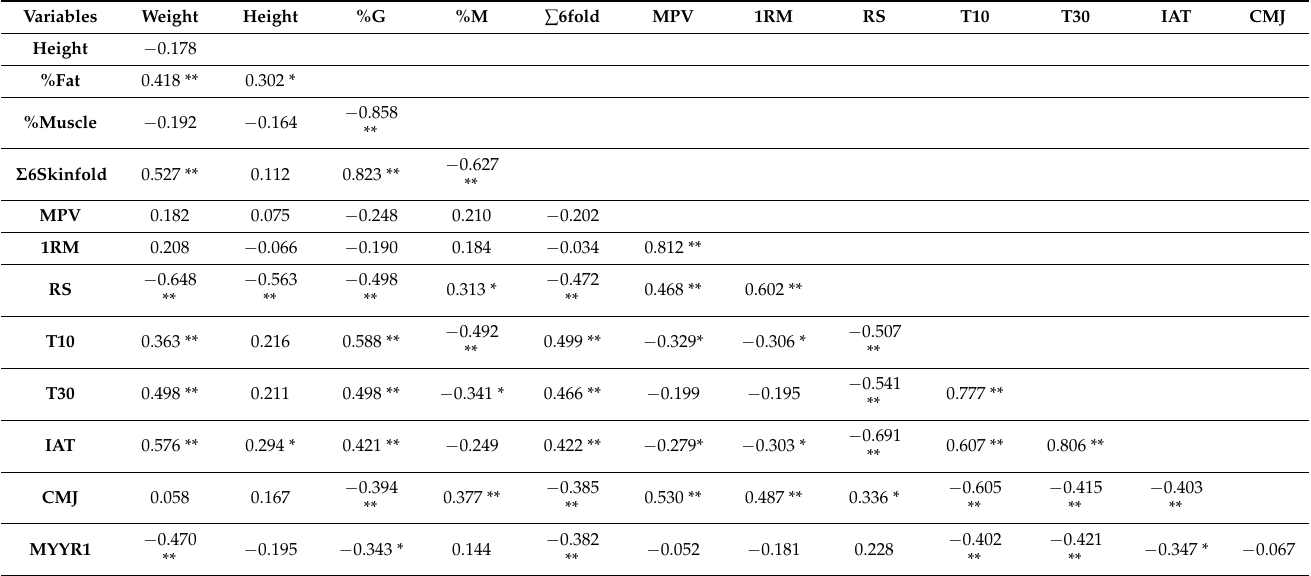
Table 3 shows the correlations between anthropometric and physical fitness variables. Table 3. Correlations between anthropometric and physical fitness variables.